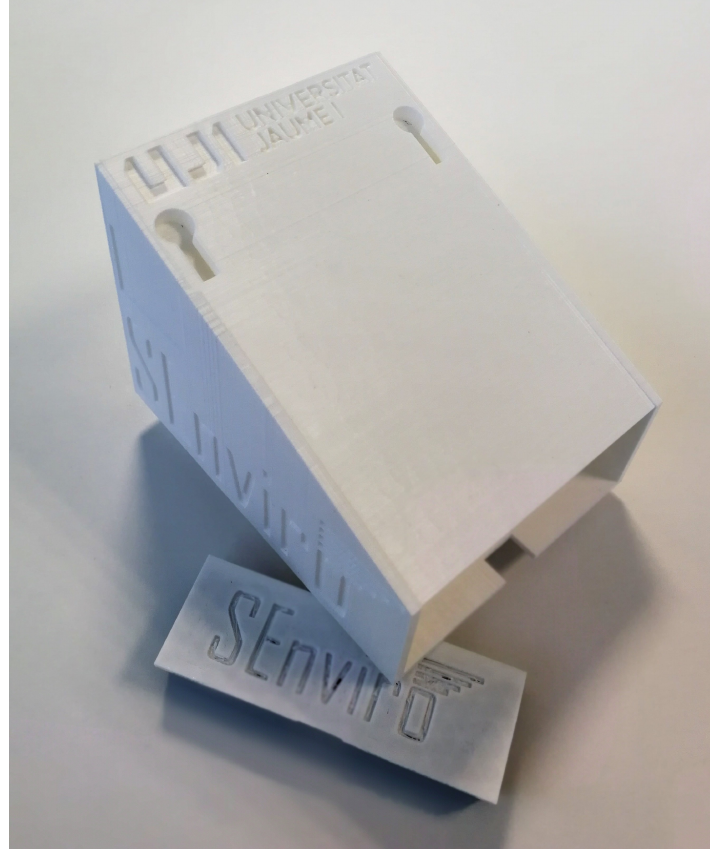
Figure 6. 3D printed